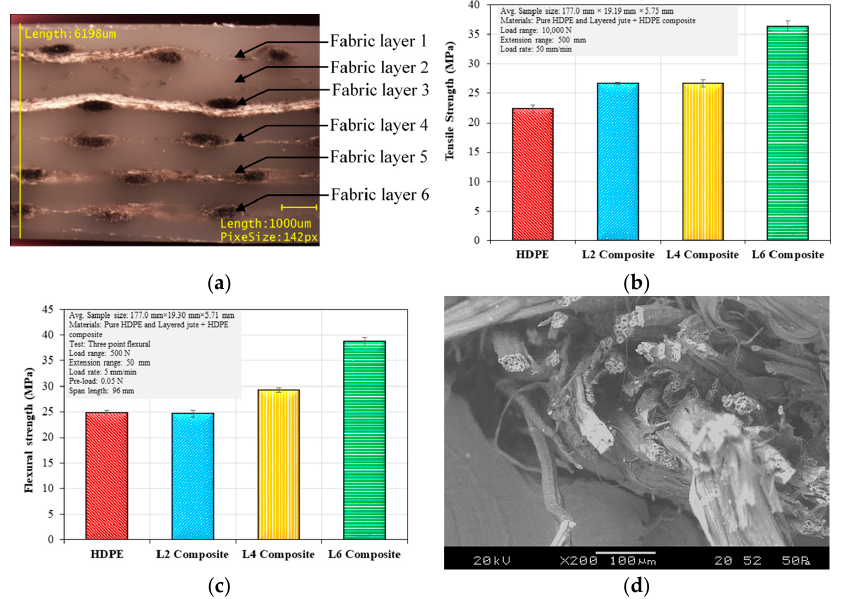
Figure 18. Mechanical properties jute-HDPE composites with varying number of jute layers: ( a ) layered composite cross-section ( b ) tensile strength ( c ) flexural strength and ( d ) tensile fracture surface [41].